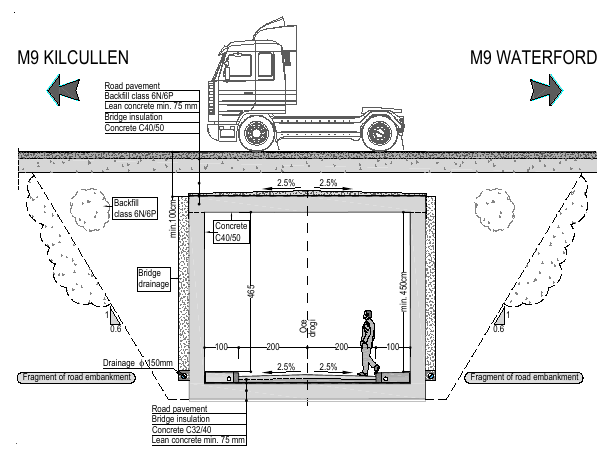
Figure 2: Cross-section of the bridge.